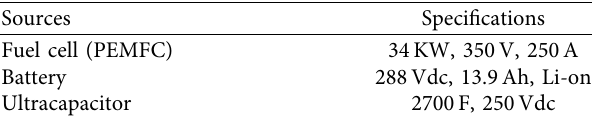
Table 5: Parameters of HESEC